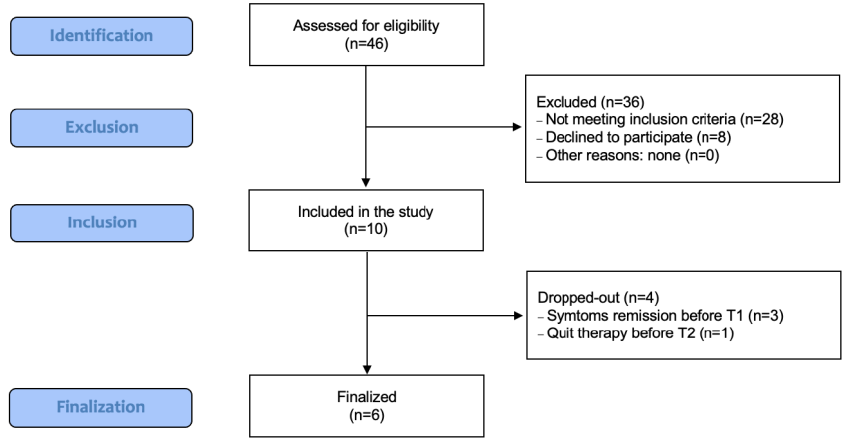
Figure 1. Flow chart of the study participants.